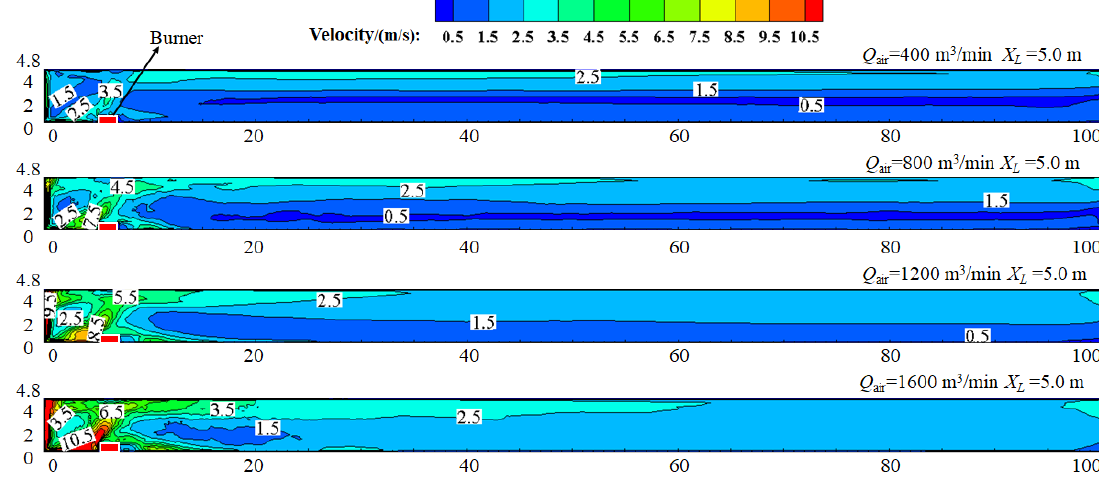
Figure 12. Longitudinal flow field distribution of the single-end tunnel under different air